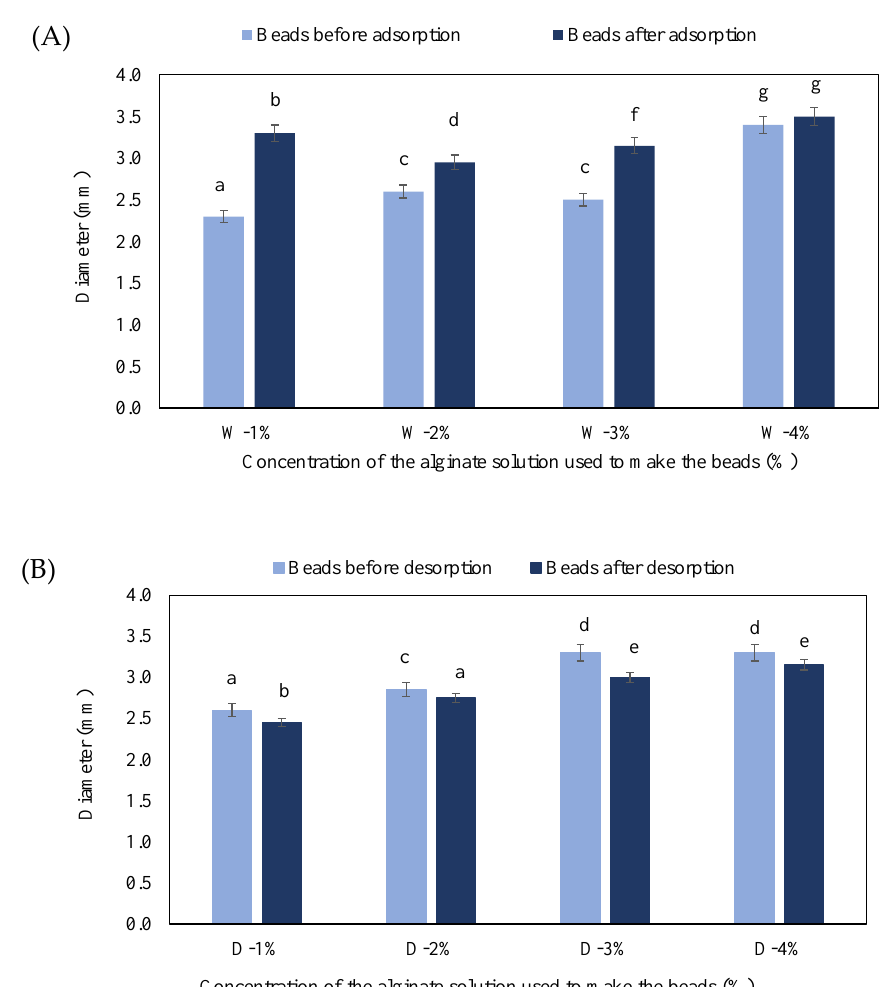
Figure 2. Diameter change of beads before and after the adsorption process ( A ) and before and after the desorption process ( B ). The letter “W” denotes plain beads made with water and subjected to the adsorption process, while the letter “D” denotes beads made with dye and subjected to the desorption process. Different letters (a,b,c,d,e) above the bars represent significant differences at p < 0.05.